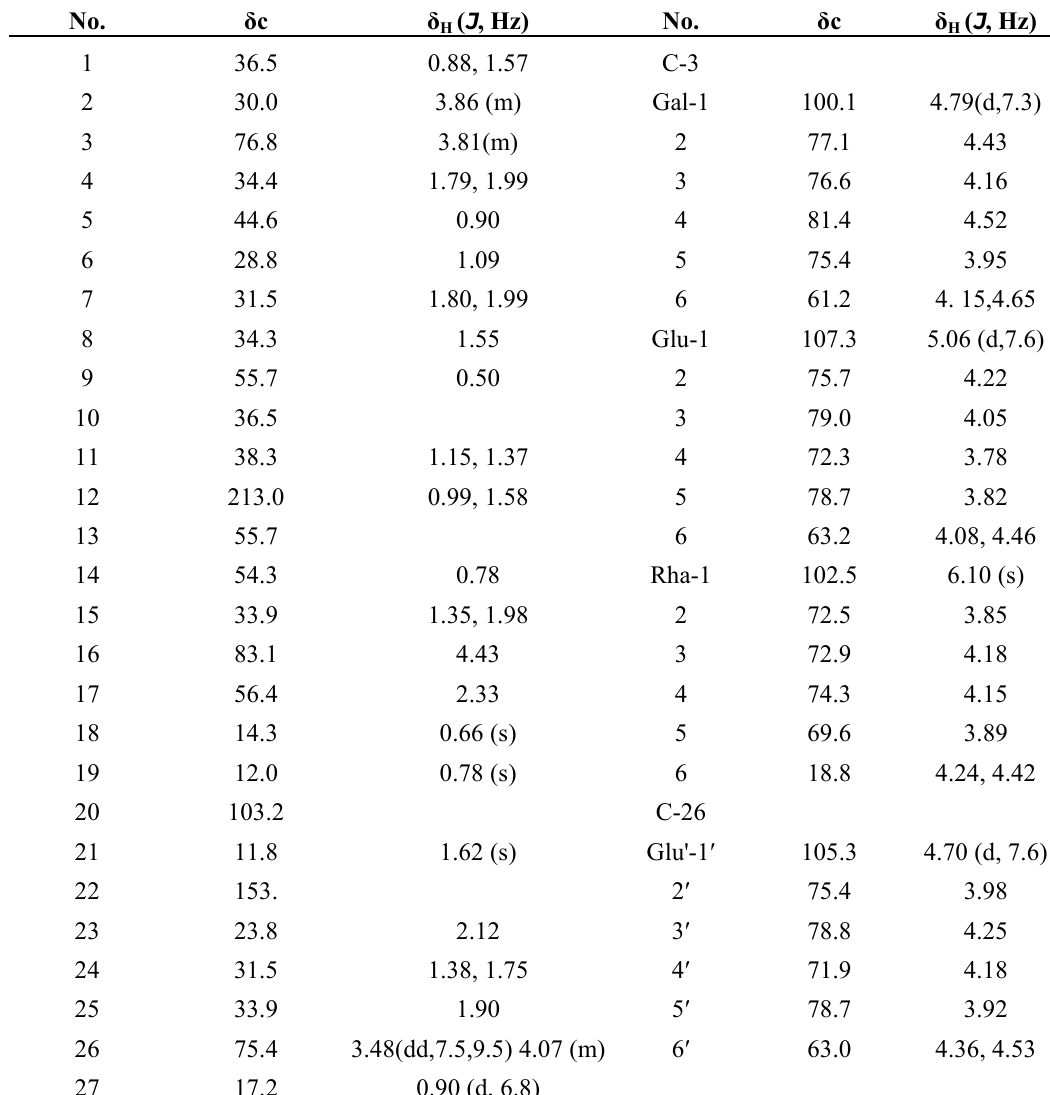
Table 1. 1 H- and 13 C-NMR spectral data of compound 1 (recorded at 500/125 MHz in ; δ in ppm, J in Hz). Pridine-d 5